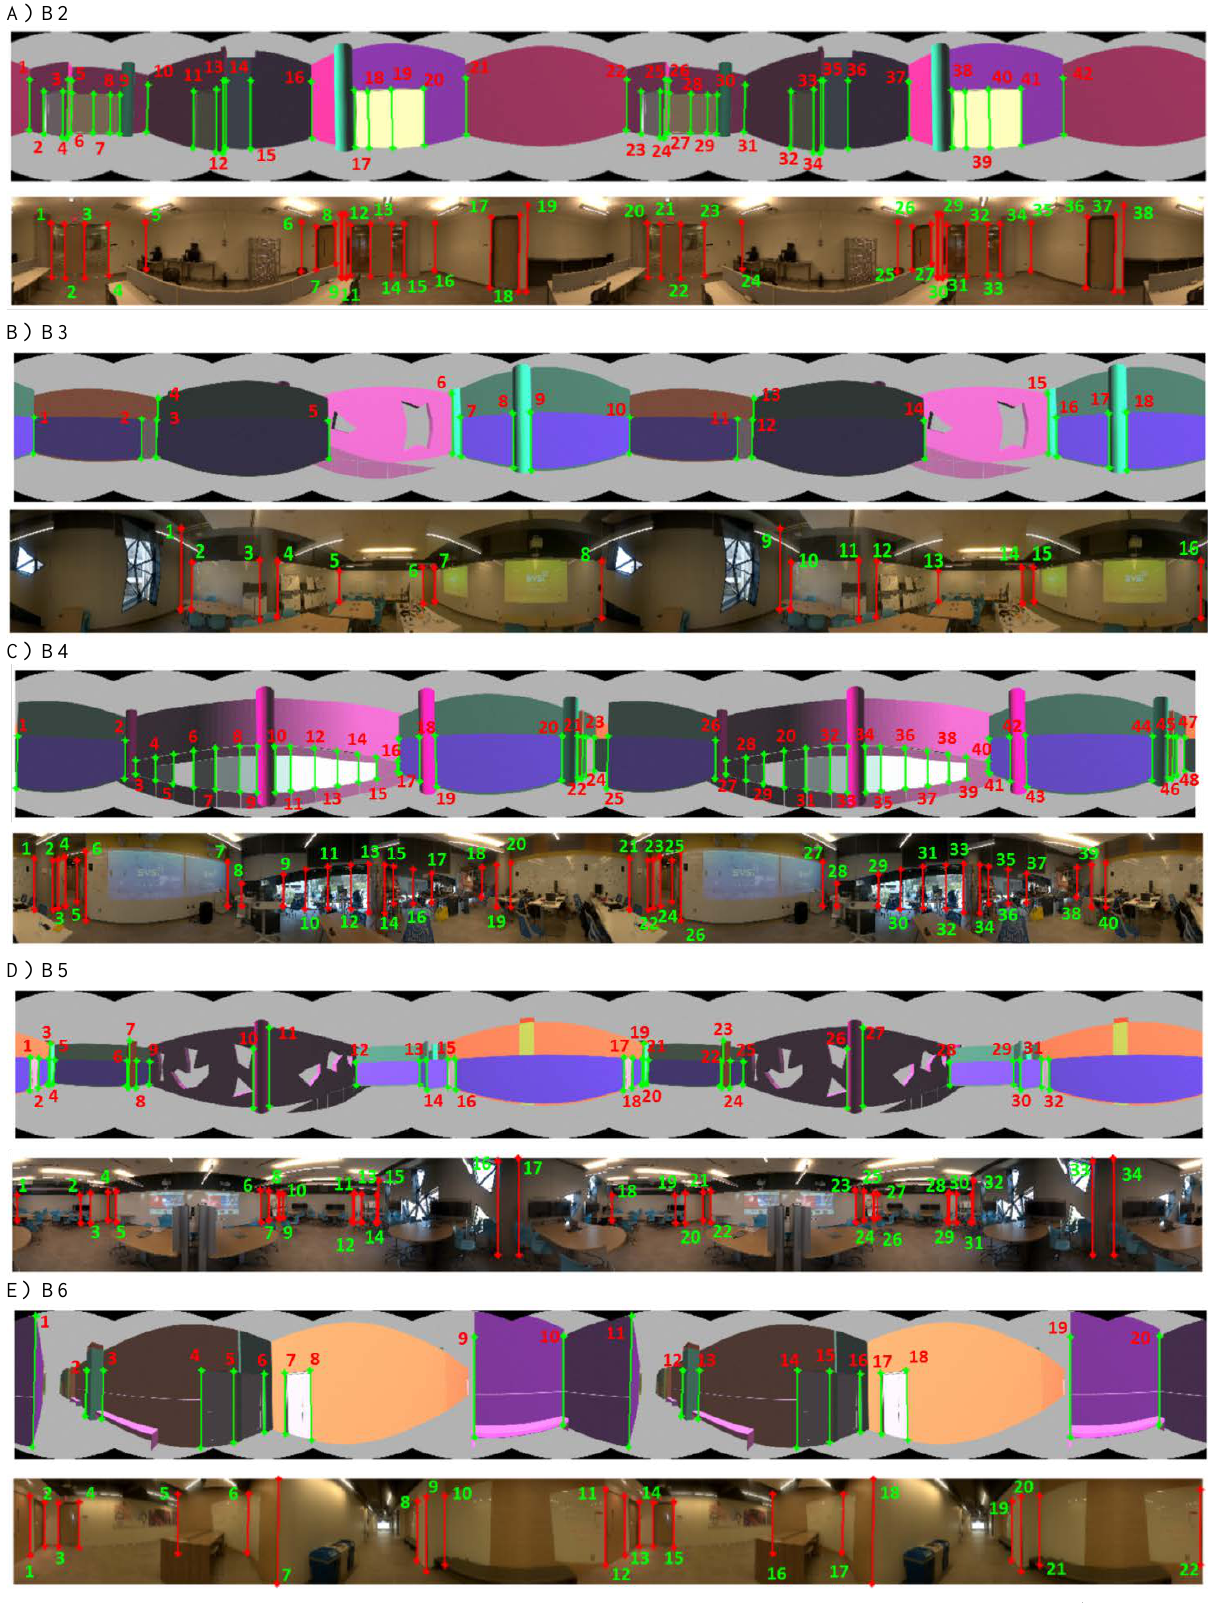
Figure 6. Input panoramic images and corresponding synthetic panoramic images captured in the Bergeron Centre in A) Room B2, B) Room B3, C) Room B4, D) Room B5, and E) B6. Vertical Line Features extracted from synthetic panoramic images and input panoramic image are shown with green lines and red lines,